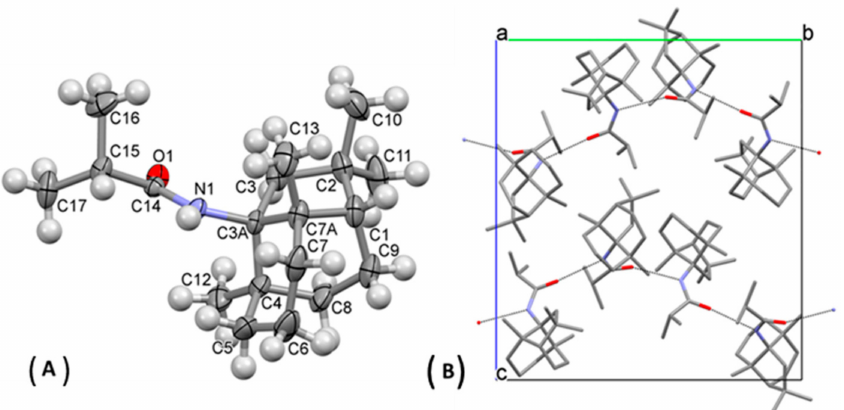
Figure 2. ( A ) Crystal structure of compound 1c (CCDC 2114089); ( B ) Molecules packing of 1c (view along a axis). Hydrogen atoms are not shown. Chains of molecules along the b axis are formed due to N-H . . . O H-bonds (H . . . O 2.20, 2.21 Å, N-H . . . O 168, 171 ◦